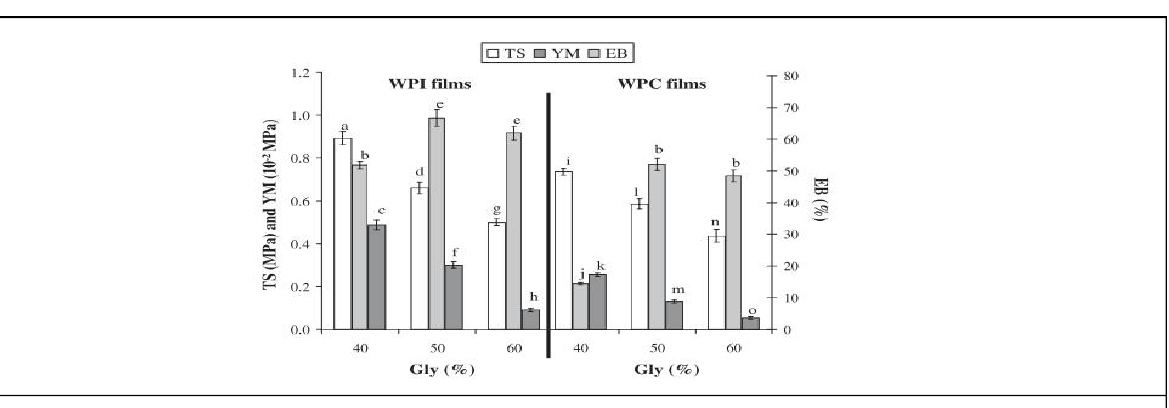
Figure 8: Values of TS, EB, and YM of 10% (w/w) WPI and WPC edible films with various contents of